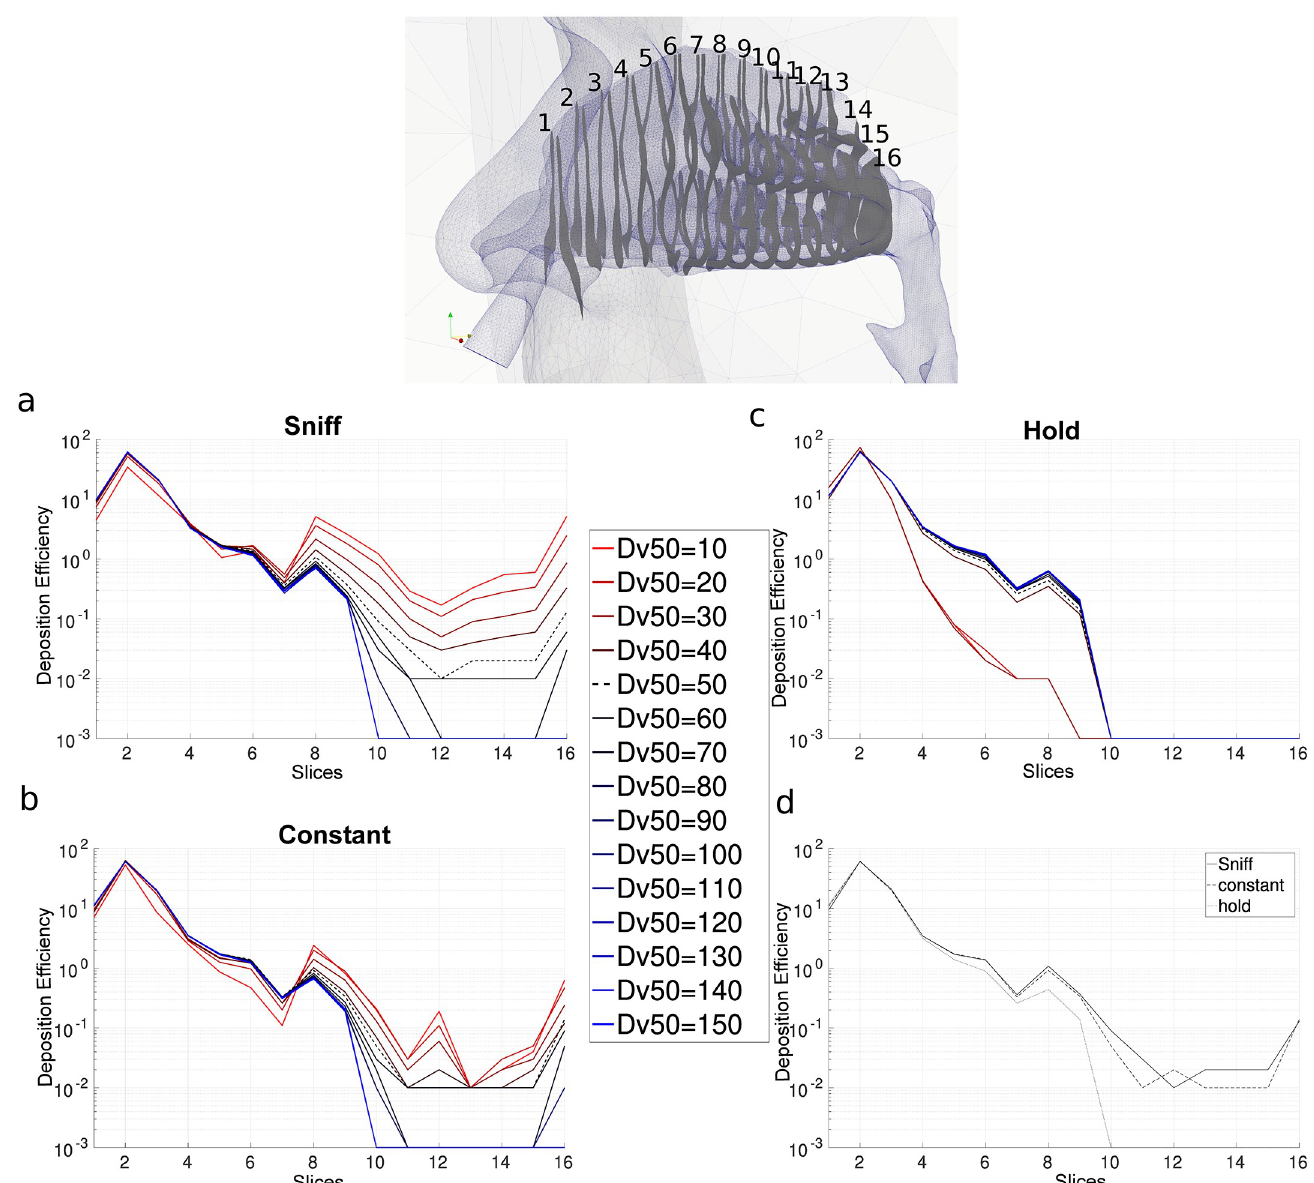
Fig 15. Particle deposition efficiency as a function of slice position; (a) to (c) corresponding to A1, A2 and A3 inhalation condition then (d) is the comparison of the three profile for Dv 50 = 50 μ m.